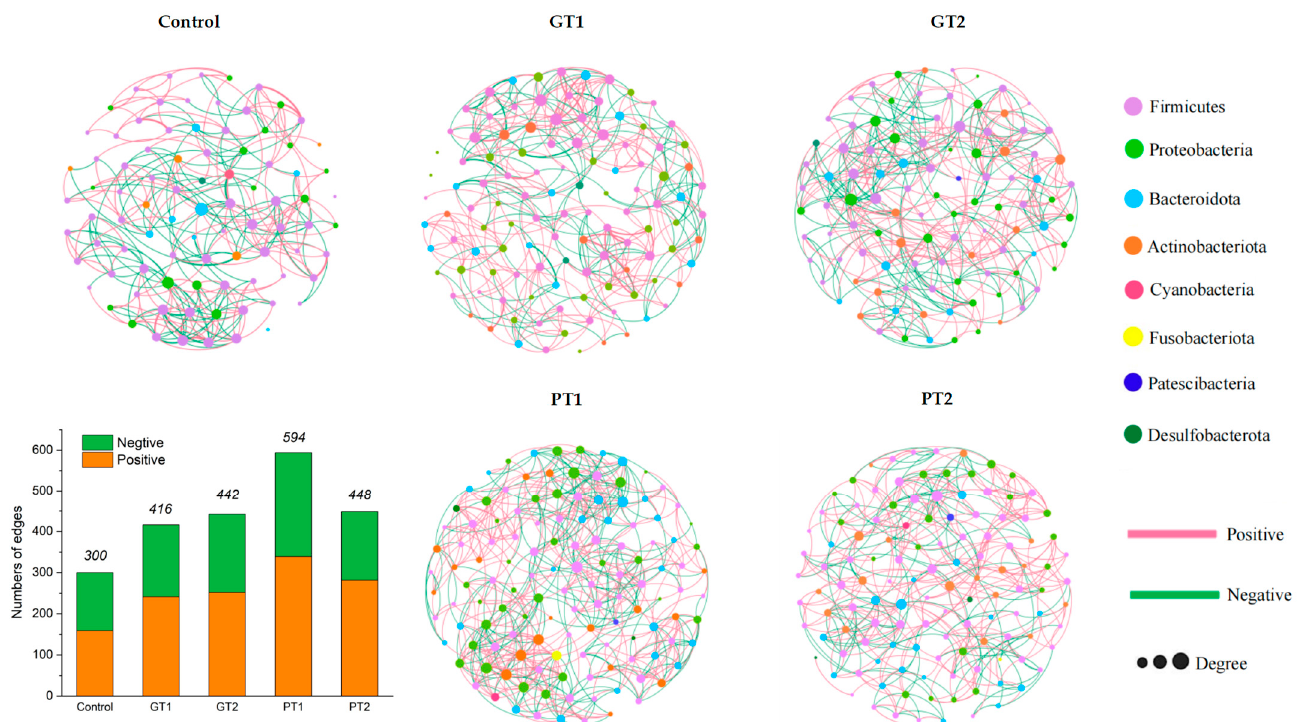
Figure 5. Effects of different disinfectant treatments on microbial networks. For easier visualization, nodes are colored according to the genera, and node size denotes the number of connections. The control represents the gut samples from the larvae fed pig manure without a disinfectant; GT1 and GT2 represent the gut samples from the larvae of GT1 and GT2; PT1 and PT2 represent the gut samples from the larvae of PT1 and PT2. The number of edges in the microbial networks that are both positive and negative is indicated. The values show the overall connections.